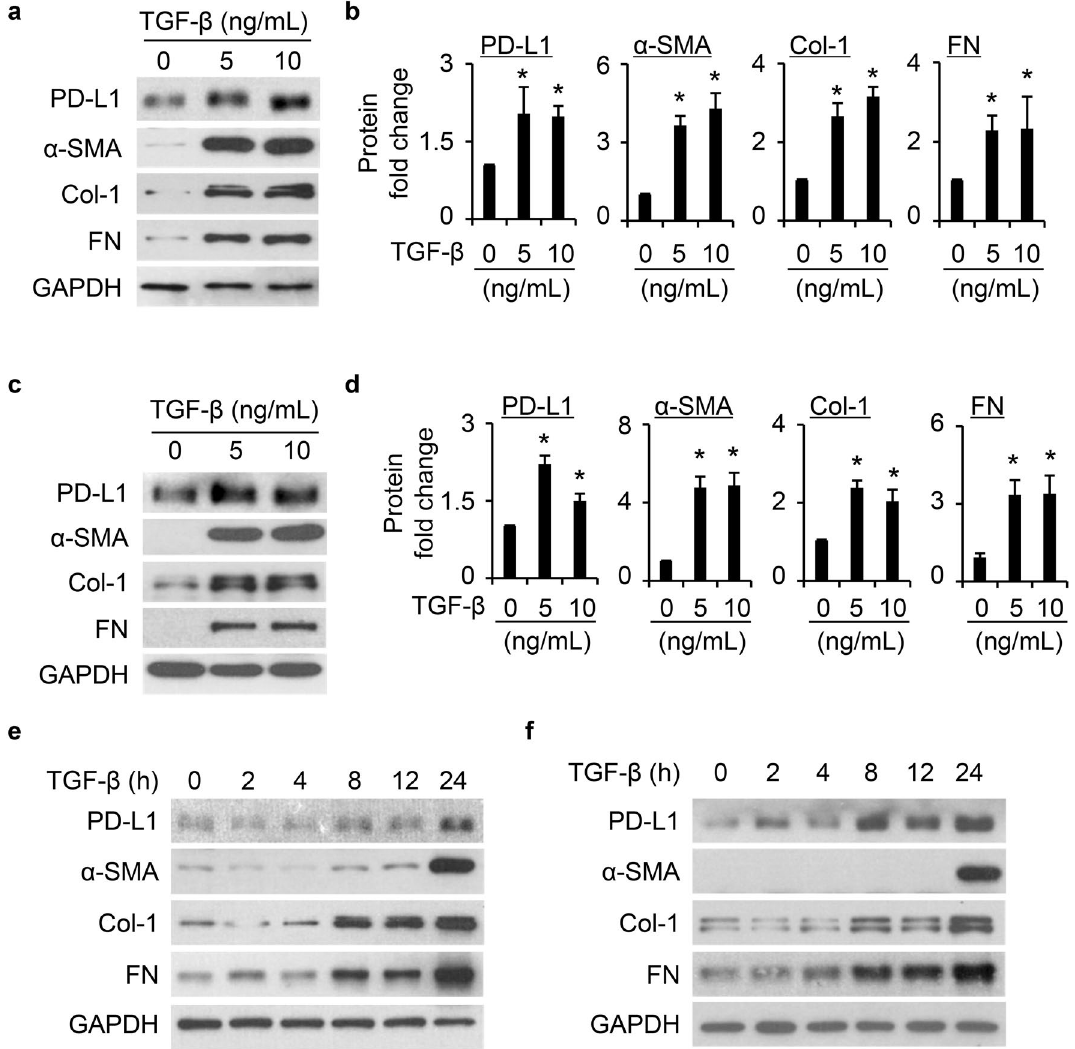
Figure 3. PD-L1 expression was induced by TGF-β in primary normal and IPF HLFs. ( a ) and ( c ), TGF-β significantly induced increase of PD-L1 levels along with α-SMA, collagen type 1 (Col-1), and fibronectin (FN) in both primary normal ( a ) and IPF ( c ) HLFs. ( b ) and ( d ) are quantification of ( a ) and ( c ), respectively, based on three independent experiments. ( e ) and ( f ), TGF-β (5 ng/mL) induced PD-L1 levels in a time dependent manner in primary normal ( e ) and IPF ( f ) HLFs. *, P < 0.05 compared with vehicle